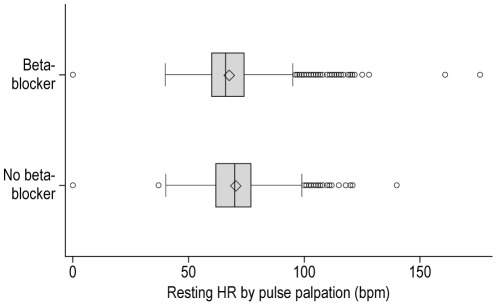
Distribution of HR for patients with versus without beta-blocker use.The vertical lines represent the minimum and maximum values. The box represents the lower (25th percentile) and upper (75th percentile) quartiles. Within the box, the vertical line is the median and the diamond the mean. Values>1.5 times the interquartile range were considered outliers and are shown as individual circles.